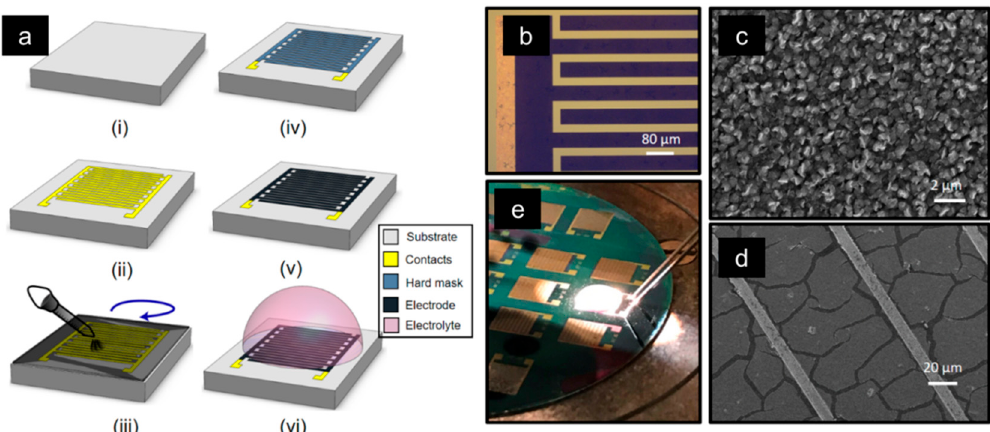
Figure 2. ( a ) Schematic CMOS compatible process for MSC fabrication. ( b ) Optical micrograph of the fabricated intedigitated reduced graphene oxide (rGO) electrodes on Au / Ti current collectors. ( c ) Graphical SEM image of vertical graphene on a 50 mm diameter Si / SiO 2 wafer with Au / Ti collectors. ( d ) SEM image of rGO on Fe / Ti / Au current collectors. ( e ) Electrochemical test setup of fabricated rGO-MSCs with H 3 PO 4 / polyvinyl alcohol (PVA) electrolyte.